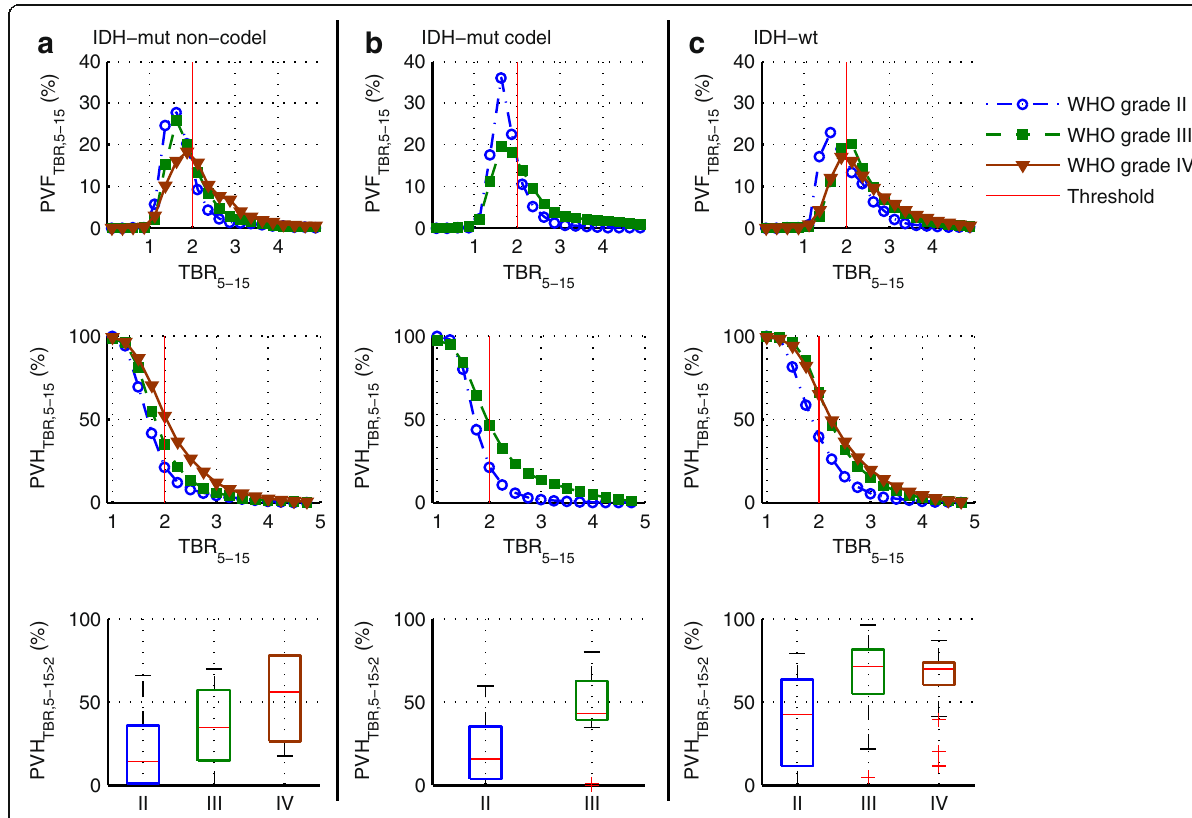
Fig. 4 Data presented as in Fig. 2, with average percentage volume fractions of the TBR (PVF TBR,5 – 15 ), the corresponding cumulated histograms (PVH TBR,5 – 15 ), and the boxplots of PVH data with TBR 5 – 15 > 2 (PVH TBR,5 – 15>2 ). a IDH -mut non-codel. b IDH -mut codel. c IDH